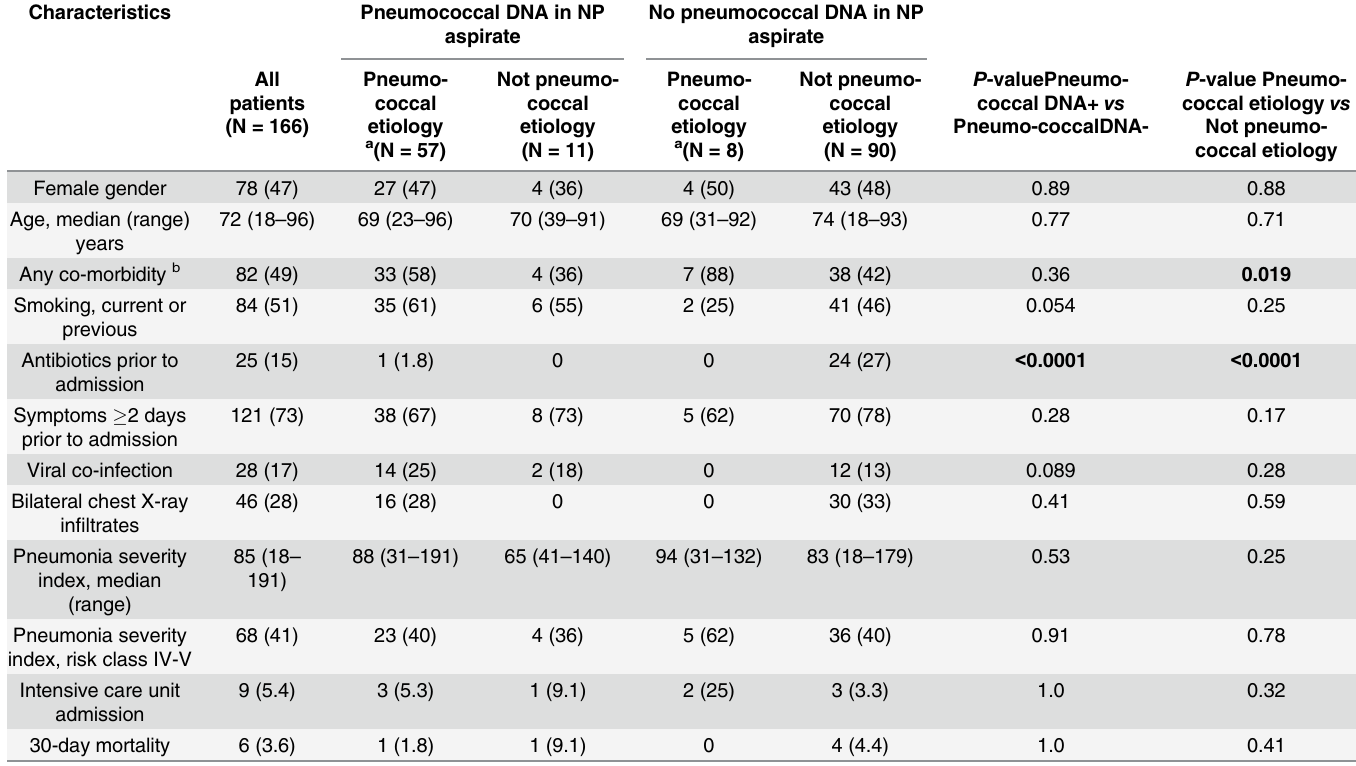
Table 1. Characteristics of patients with community-acquired pneumonia with pneumococcal DNA detected and not detected in nasopharyngeal (NP) aspirate.